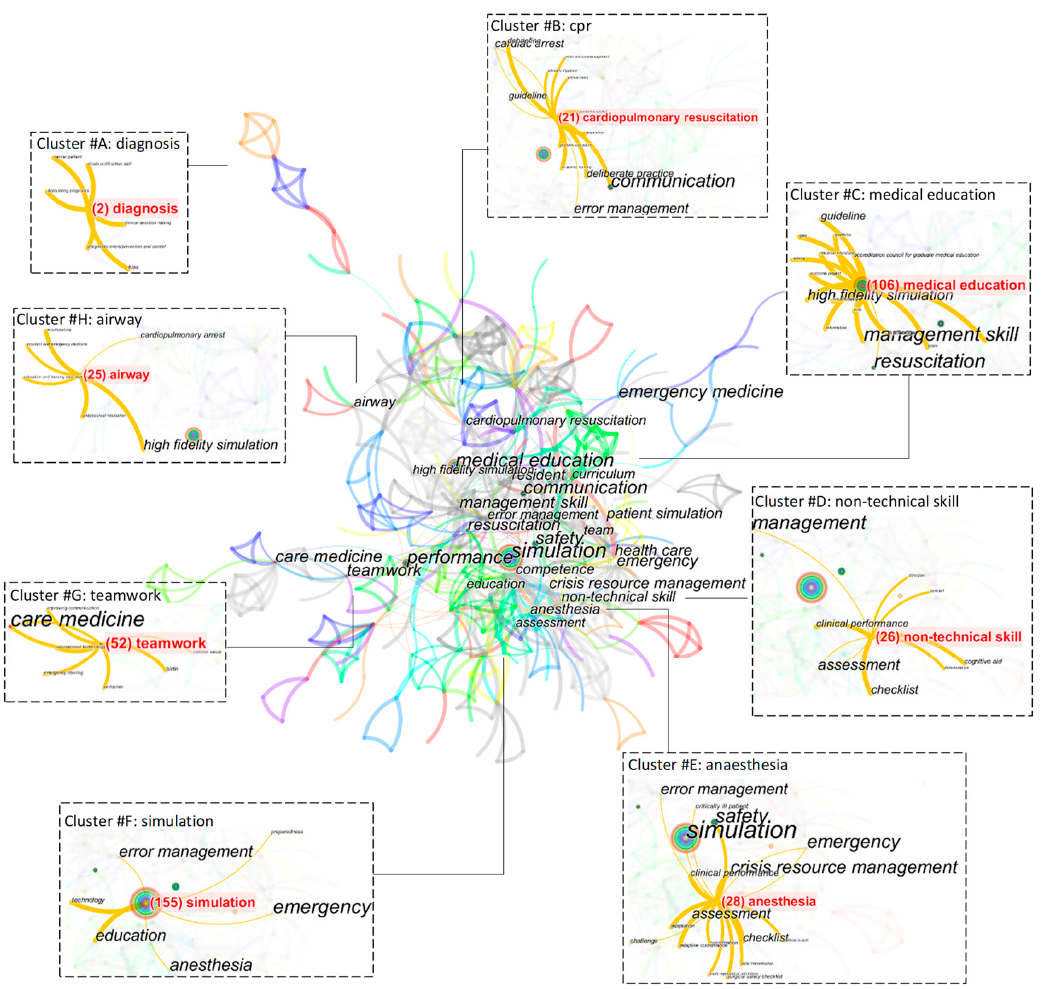
Figure 6. Cluster view of keyword concurrences between 2001 and 2020.